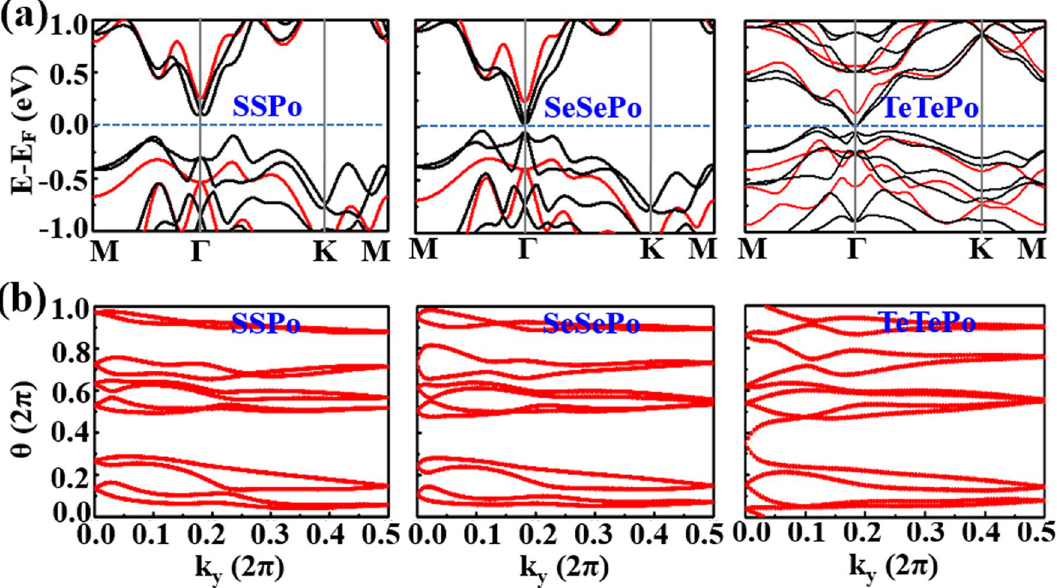
Figure 5. ( a ) Band structures of the XXPo (X = S, Se, Te) MLs without (red curves) and with (black curves) SOC. ( b ) gives the corresponding Wannier charge